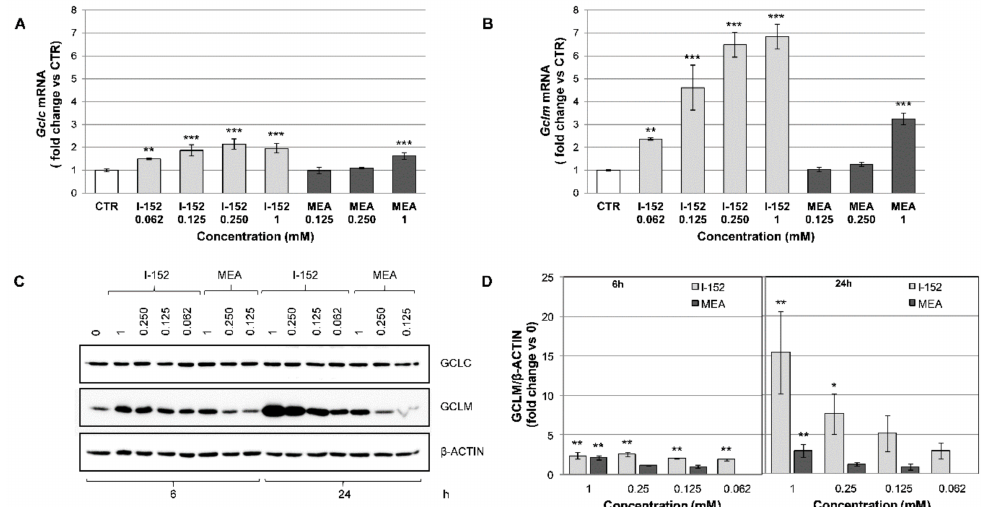
Figure 5. NRF2-dependent gene transcription and protein expression. RAW 264.7 cells were exposed to different concen- trations of I-152 and MEA for 6 h and 24 h. ( A , B ) RTqPCR analysis of Gclc and Gclm mRNA levels after 6 h of treatment. mRNA levels were normalized to the housekeeping genes Gapdh and Gusb and expressed as fold-change versus untreated cells (CTR). The values are the mean ± SD of at least two independent experiments with two technical replicates. ( C ) West- ern immunoblotting analysis of GCLC and GCLM protein expression. Cell lysates (5 µ g) were separated on 10% ( w/v ) gels and immunoblotted with specific antibodies against the target proteins. β -ACTIN was stained as a loading control. ( D ) Immunoreactive bands were quantified with the Image Lab software. GCLM levels, normalized to β -ACTIN content, are reported in the graphs as fold change relative to control (0). Values are the mean ± SD of at least three independent experiments. * p < 0.05; ** p < 0.01, *** p <